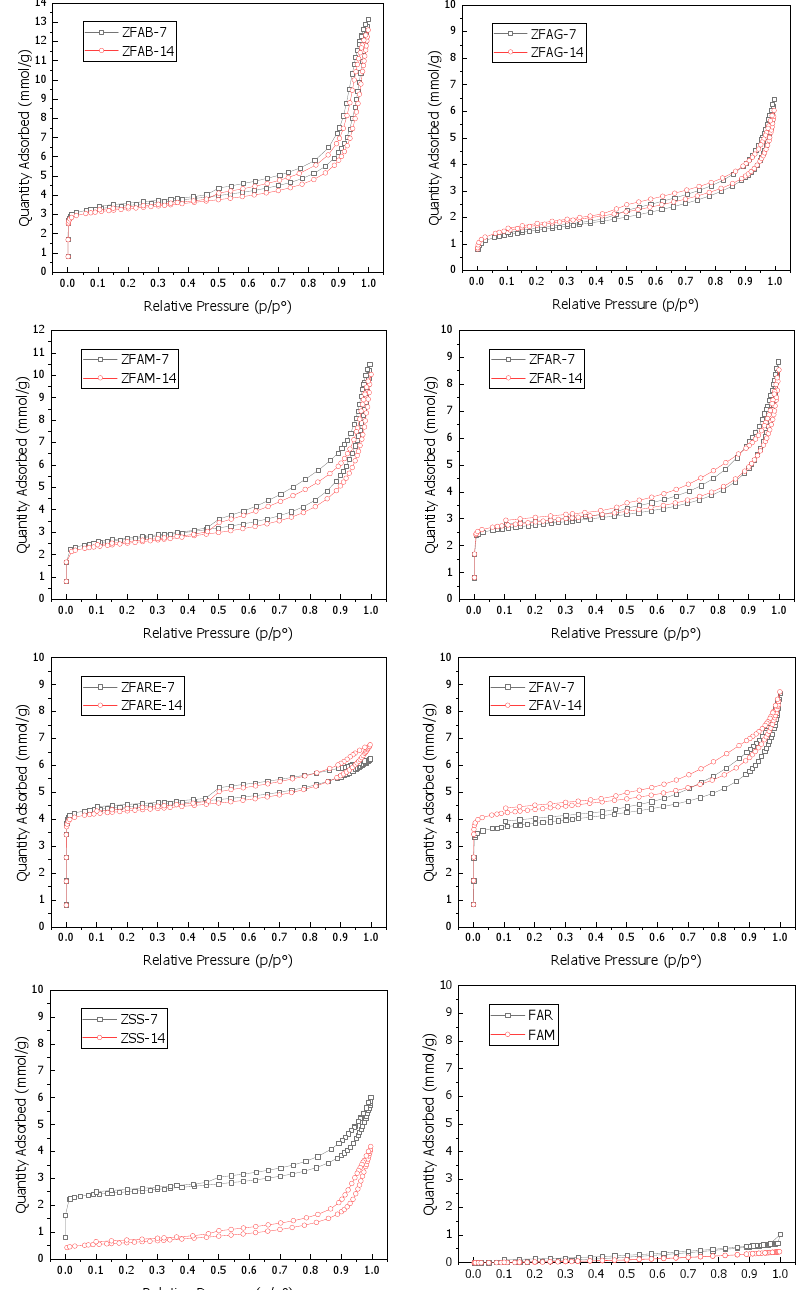
Figure 4. Isotherms of N 2 -adsorption/desorption of FAs and FAZs obtained from different raw materials for 7 and 14 months.